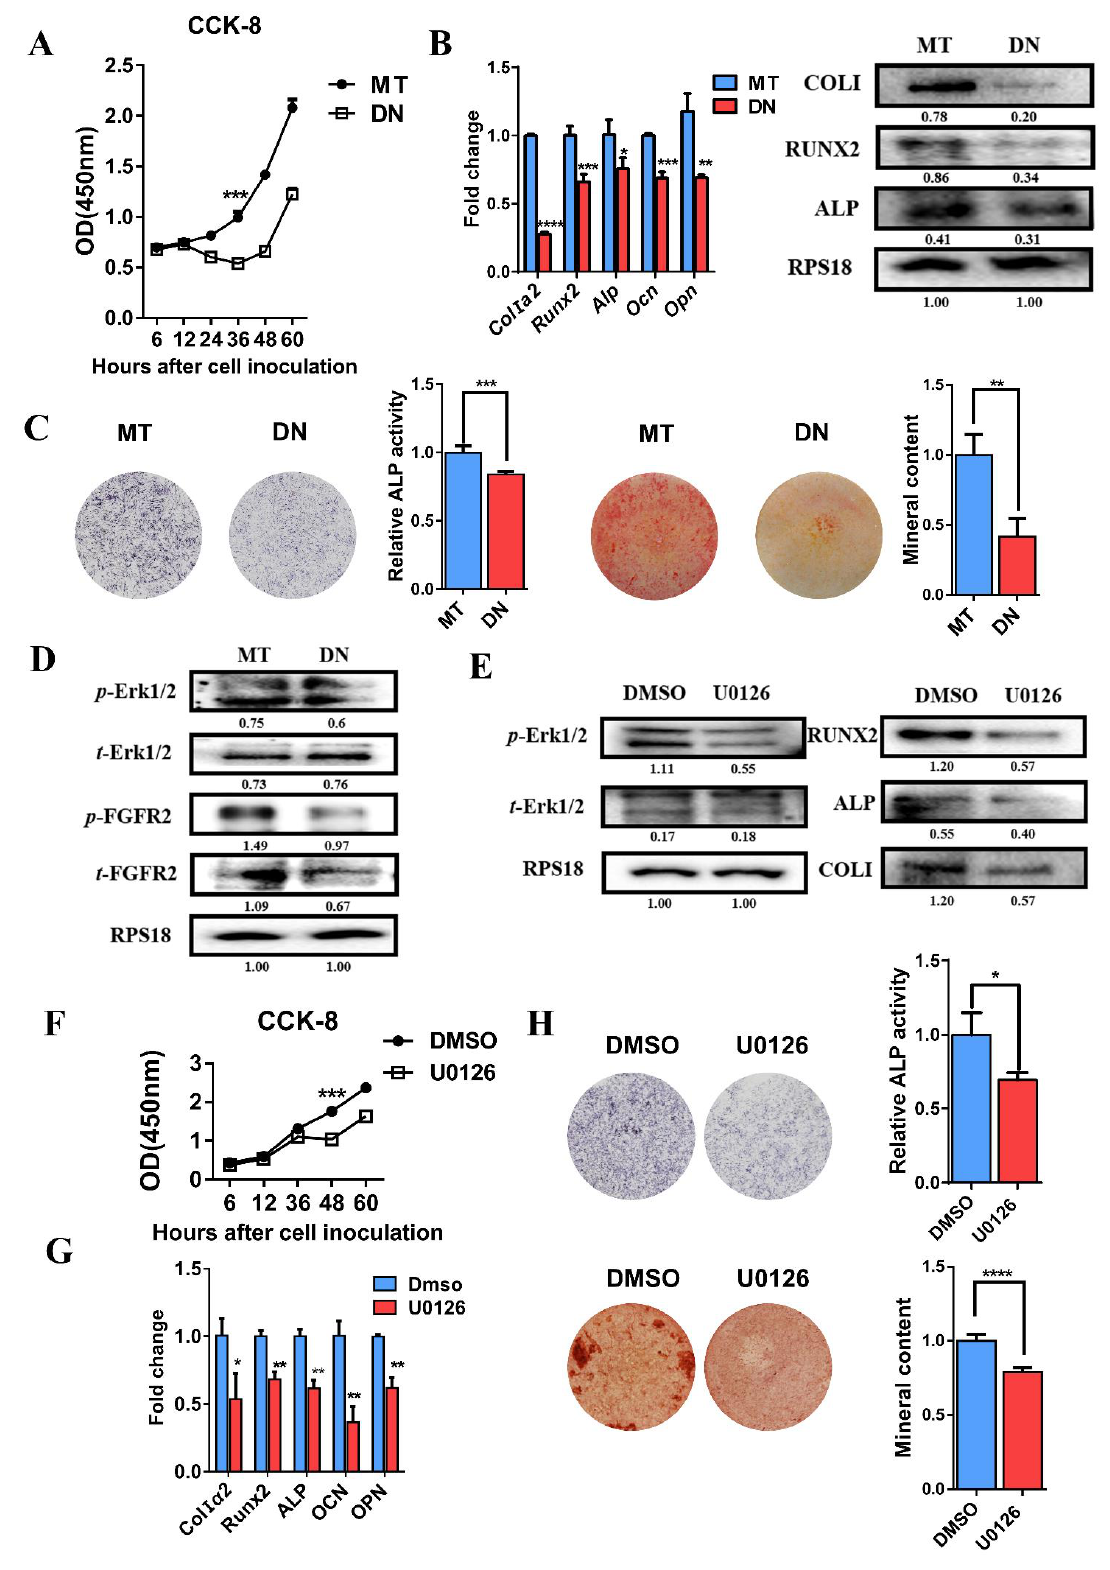
Figure 4. Domain negative FGFR2 weakened osteogenesis through the Erk1/2 signaling pathway: ( A ) CCK-8 assays showed the proliferation of MC3T3-E1 cells was inhibited in the DN FGFR2 group compared with the MT group. ( B ) Relative expressions of osteogenic genes such as ColI α 2 , Runx2 , Alp